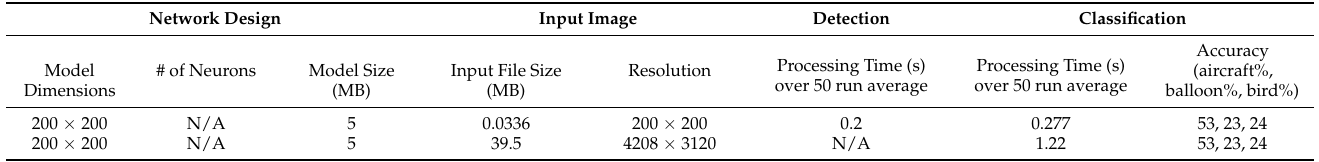
Table 2. Baseline Microsoft custom vision models.